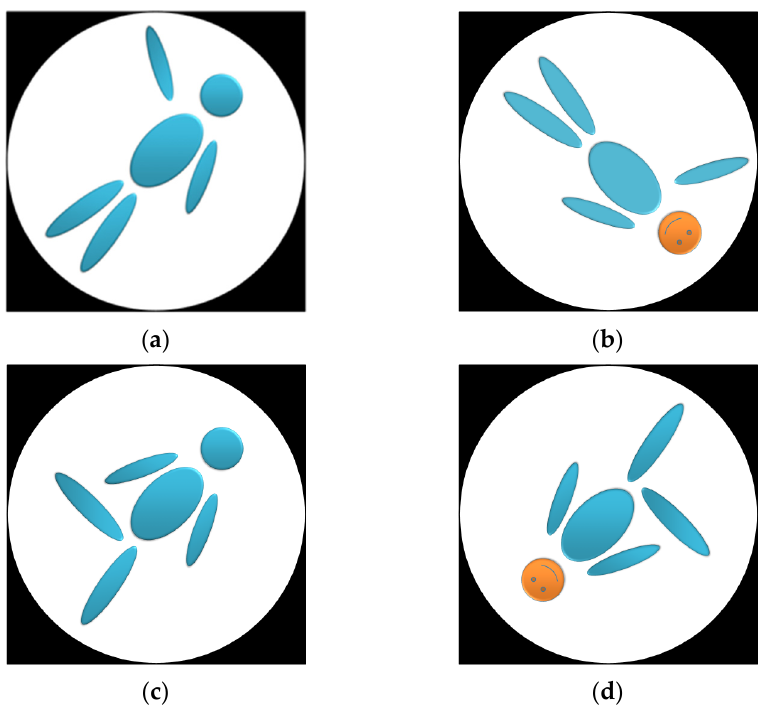
Figure 1. Depiction of the abstract stimuli in Study 1. ( a ) Back view of the left arm raised. ( b ) Front view of the right arm raised. ( c ) Back view of the left leg raised. ( d ) Front view of the right foot raised.